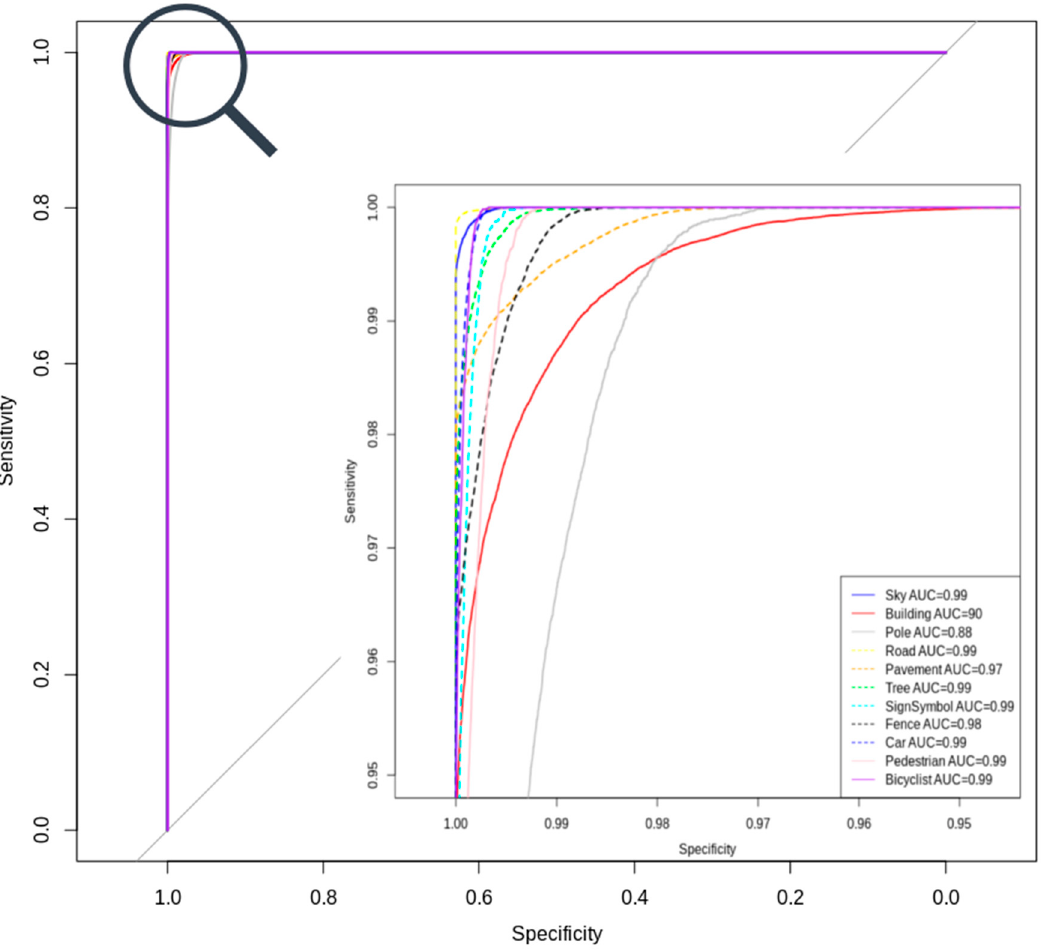
Figure 6. Left: receiver operation characteristics (ROC) curves obtained for DeepLabV3+ architecture for semantic segmentation. Zoomed view of the selected area is shows in the right figure. Area under the curve (AUC) values for each method is reported in the legend.